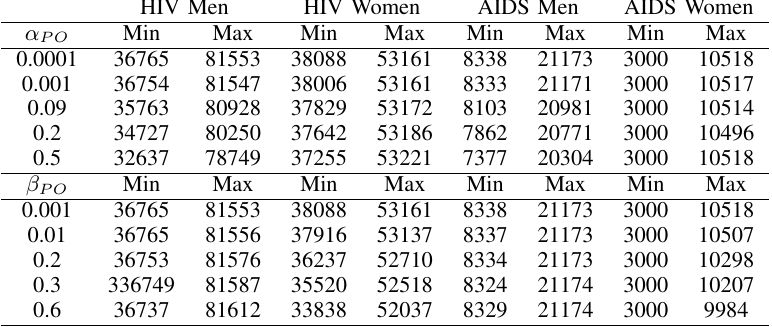
Table VI: Minimum and maximum values for α PO and β PO for the different HIV/AIDS compartments. HIV Men HIV Women AIDS